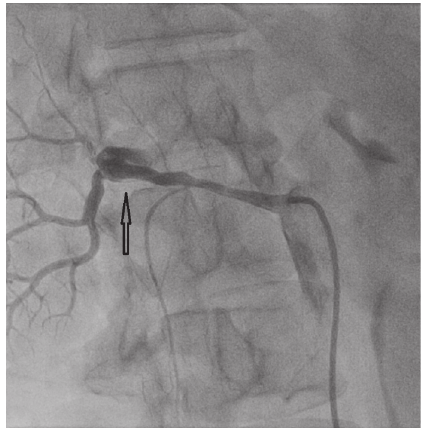
Figure 2: Right renal angiogram showing dissection of the right renal artery